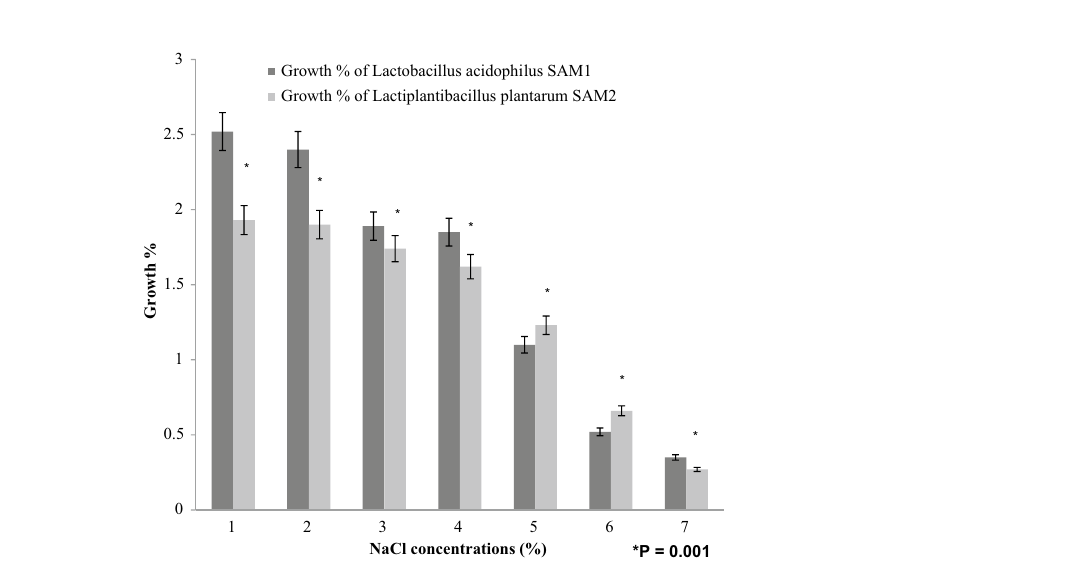
Figure 6. Effect of NaCl concentration on the growth of LAB